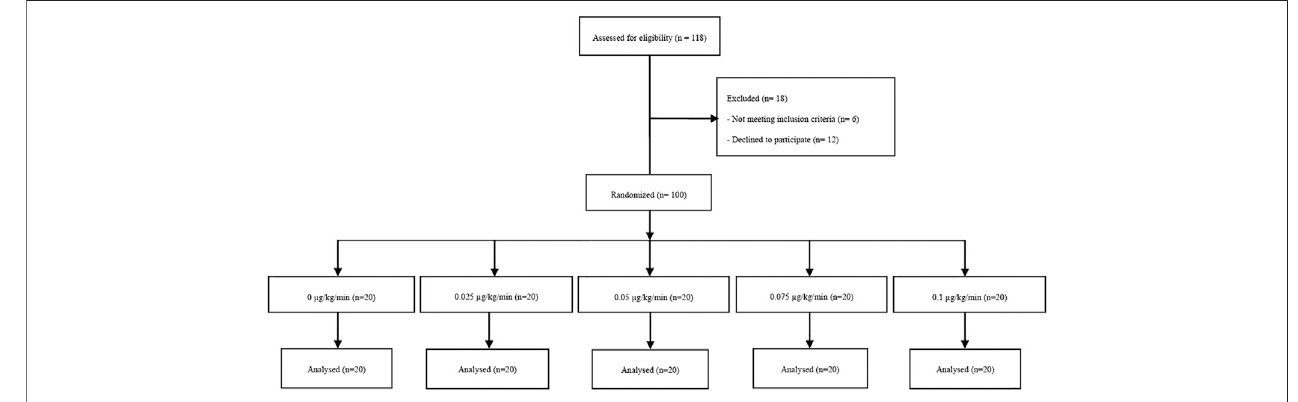
FIGURE 1 | Consort Flow Diagram.